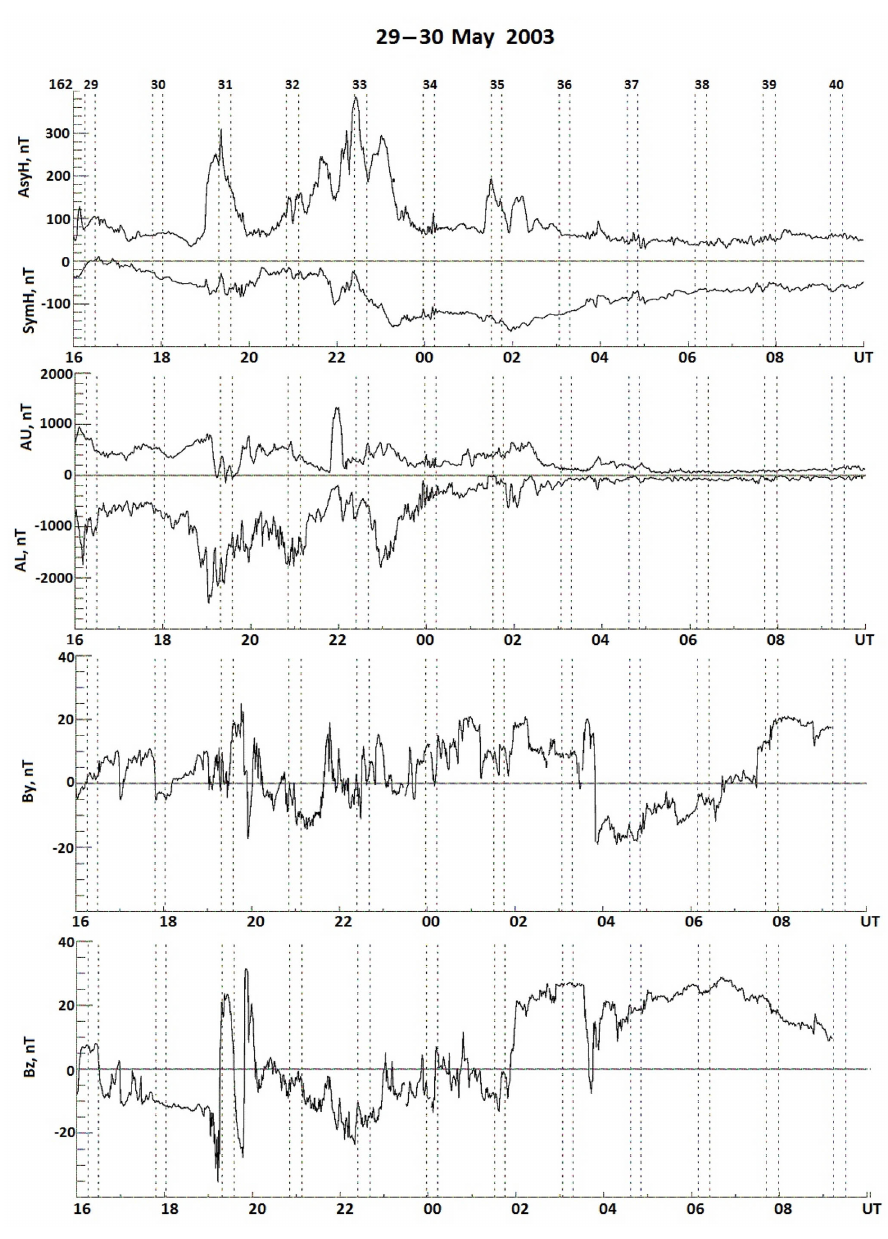
Figure 1. One-minute values of the AsyH, SymH, AU, and AL indices and of the B y and B z components of the IMF for the storm on 29–30 May 2003 (analyzed interval from 16:00UT on 29 May to 10:00UT on 30 May 2003, orbits 16229–16240). The paired vertical dashed lines indicate the UT time intervals of each satellite crossing over the northern polar cap. The orbit numbers are split into two parts; the two digits above the uppermost frame denote the last two digits of the orbit numbers of the CHAMP passes, while the first three digits are indicated at the upper left